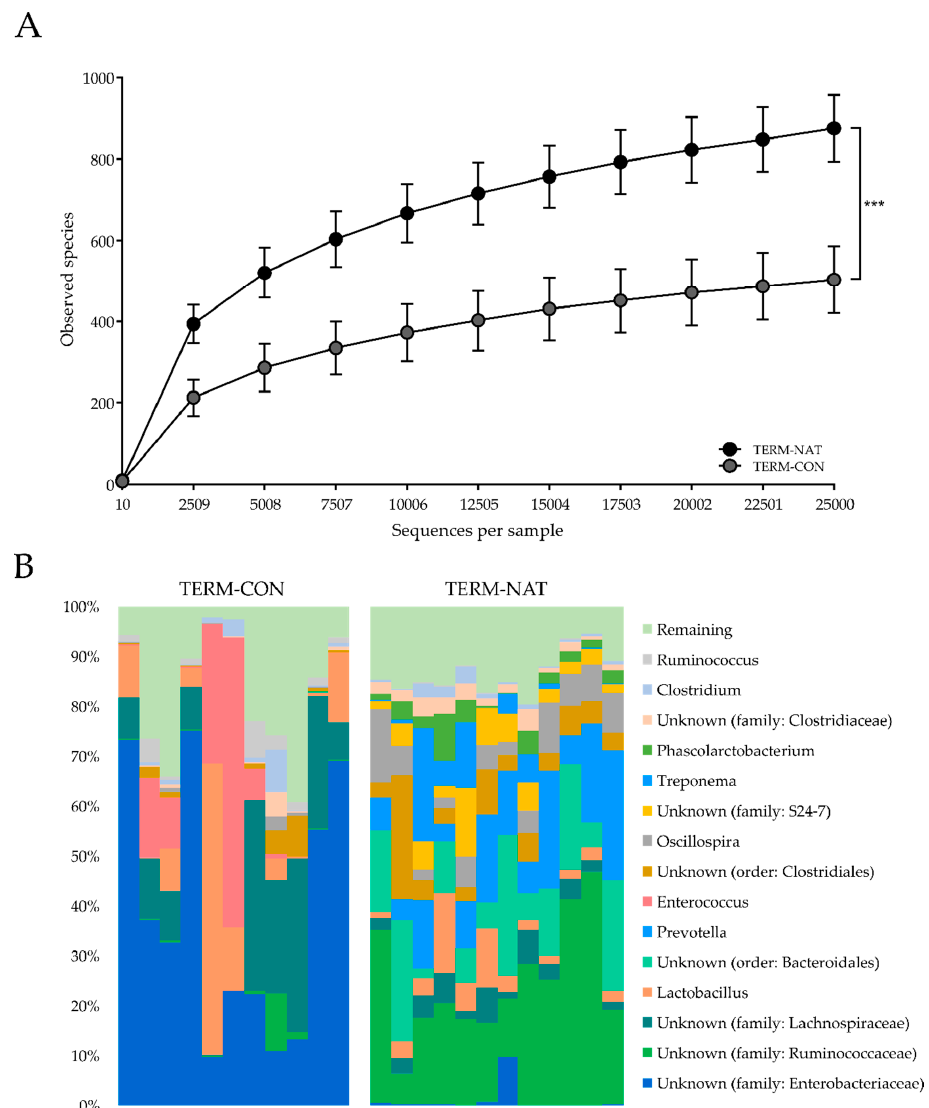
Figure 6. Microbiology in near-term pigs (Experiment 2). ( A ) Microbial diversity in colon of near-term pigs shown by the number of observed species. ( B ) Relative microbial abundance in colon for each near-term pig as determined by 16S rRNA gene amplicon sequencing. Values are presented as mean ± SD. The *** indicate statistical significant difference between groups of p <